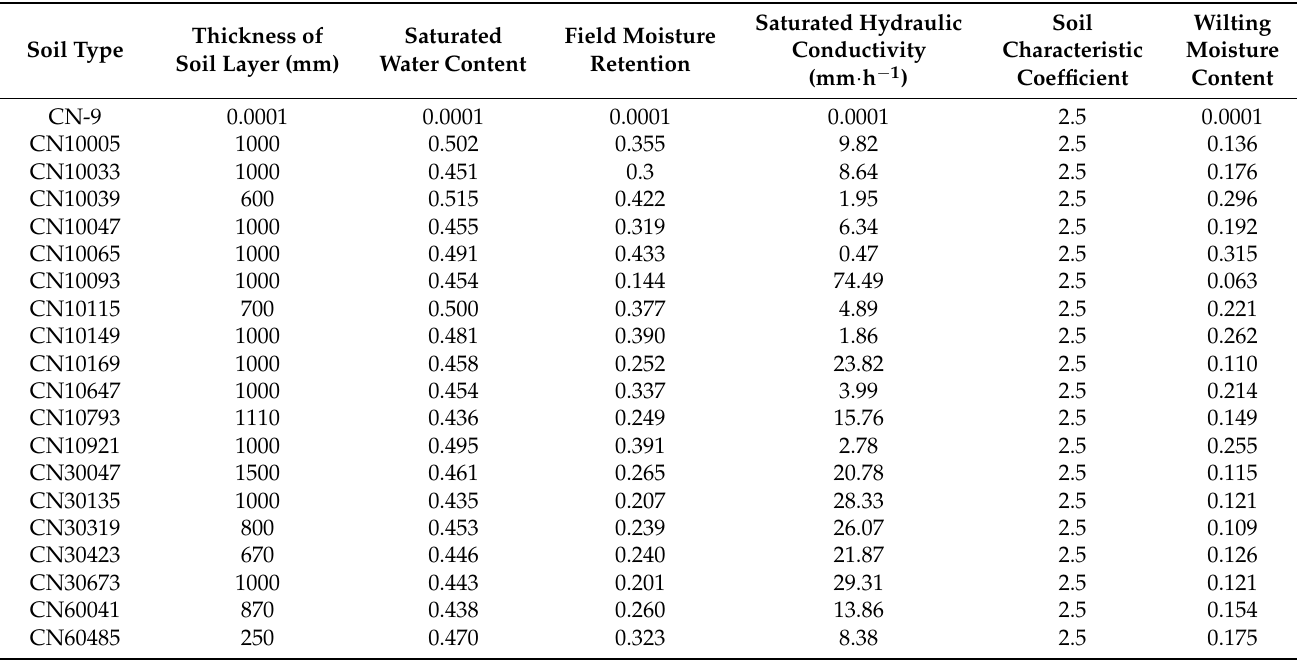
Table 3. Soil-type